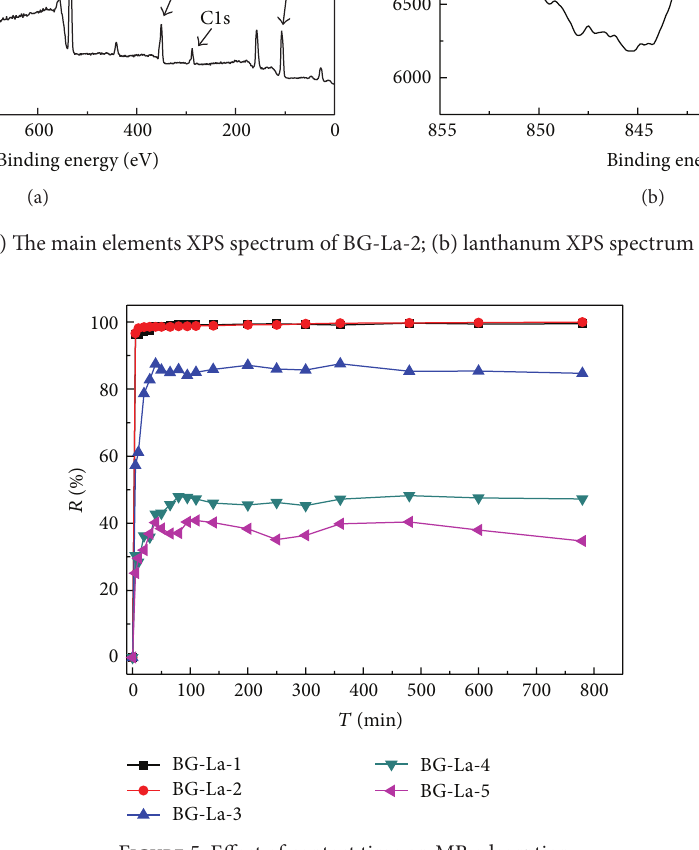
Figure 5: Effect of contact time on MB